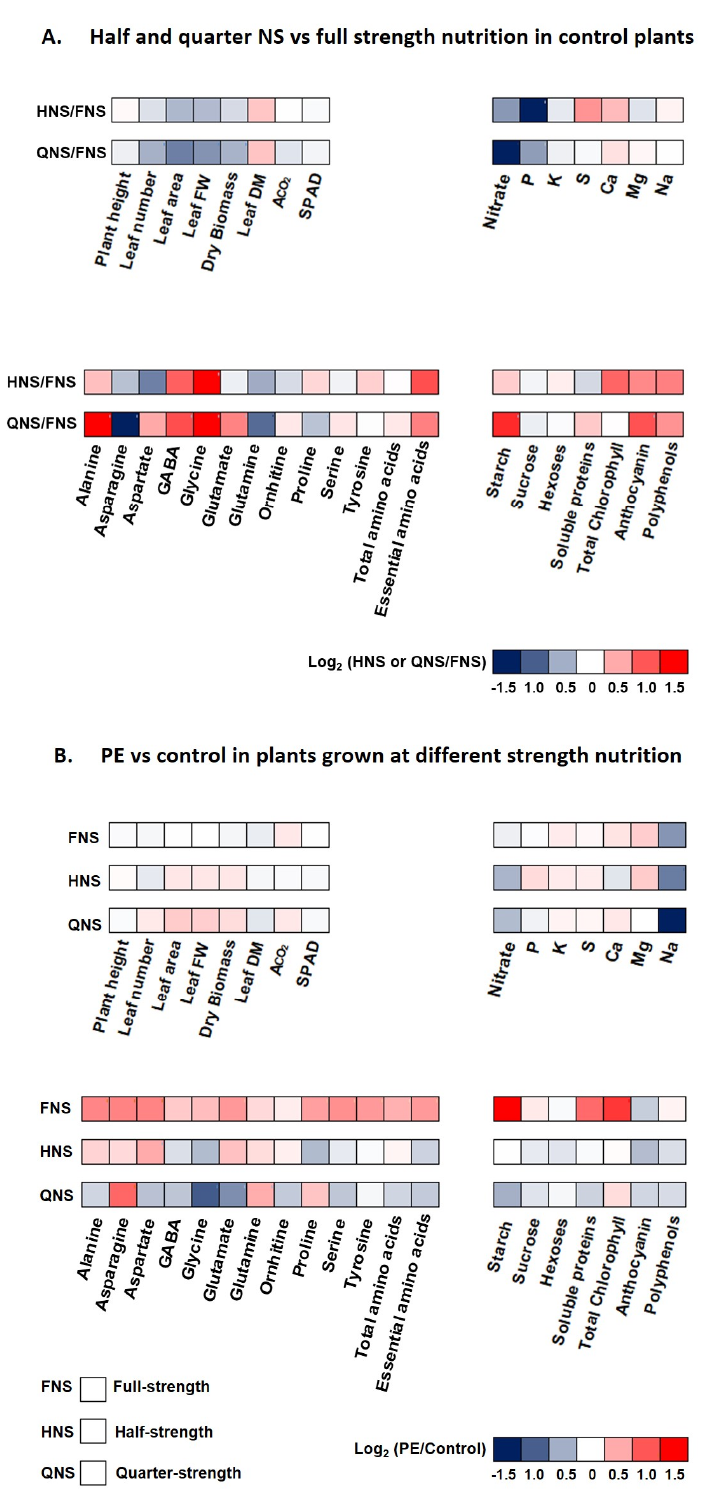
Figure 2. Heat map analysis summarizing the plant response to di ff erent nutrient solution (NS) concentrations (full-strength (FNS), half-strength (HNS), and quarter-strength (QNS), and tropical plant extract (PE) biostimulant). Results were calculated as Logarithm base 2 (Log2) of HNS and QNS / FNS in ( A ) control plants or ( B ) PE / control in plants grown at di ff erent NS, and are visualized using a false color scale with red indicating an increase and blue a decrease. White squares denotes no di ff erences.